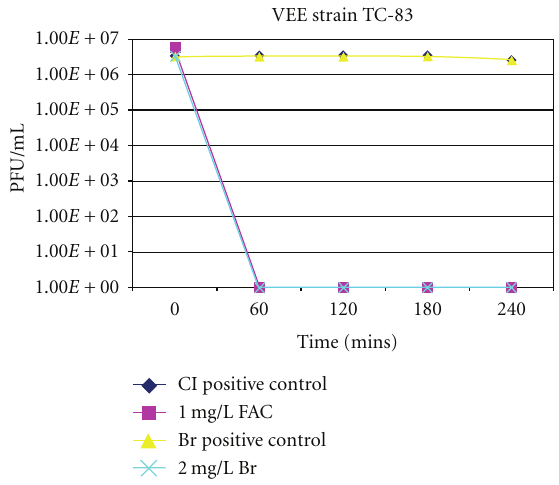
Figure 2: Survival of VEE strain TC-83 in formulated tap water with 1mg/L FAC and 2mg/L total bromine. Positive control samples consisted of formulated tap water without disinfectant. All samples were incubated at 21 ◦ C, and, at intervals, viral titers were determined as described in Materials and